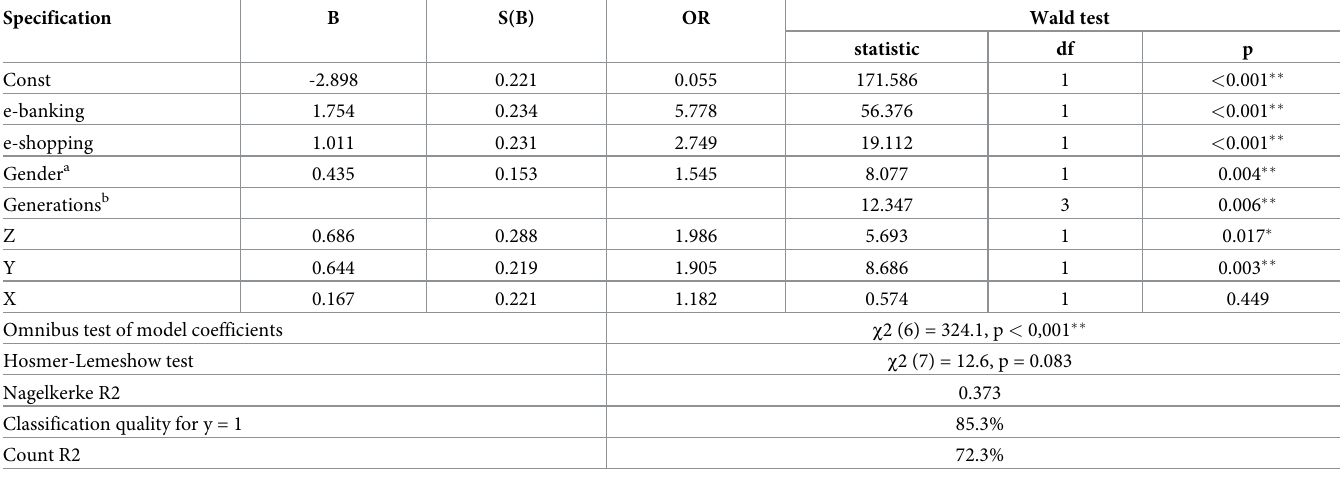
Table 8. Probability of the SE openness (SEOD) in the context of the generations–logistic regression results (model 2). Specification